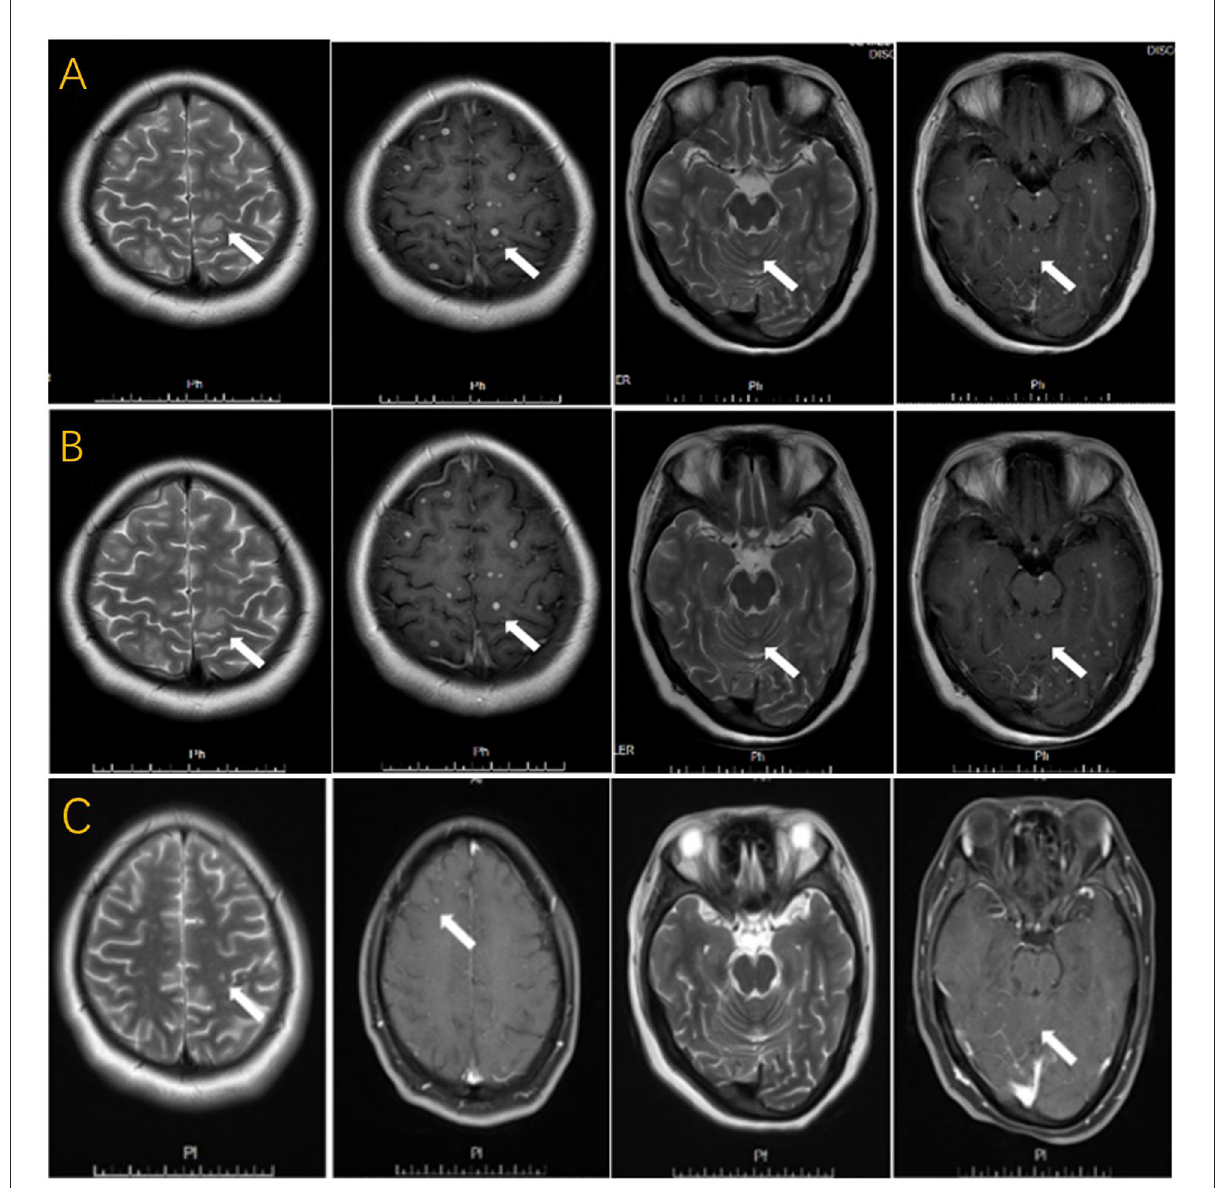
FIGURE2 (A) T2-weighted image with multiple patchy hyper-intensity signals and “target sign”. T1-weighted post-gadolinium contrast image with multiple nodular enhancing lesions, similar to military tuberculosis. (B) T2-weighted image and T1-weighted post-gadolinium contrast image done after regular ATT for a month with no significant improvement. (C) T2-weighted image and T1-weighted post-gadolinium contrast image done after intrathecal injections for one month with significant decreased